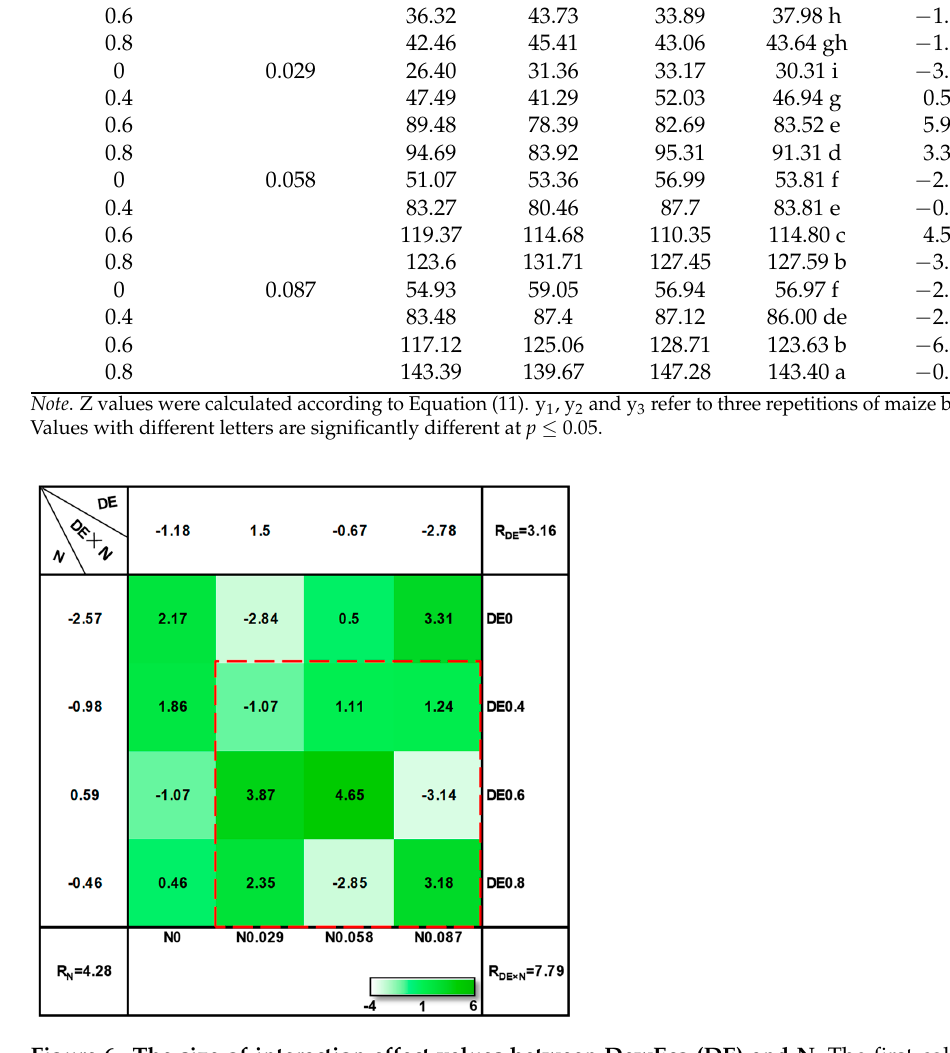
Figure 6. The size of interaction effect values between DewEco (DE) and N. The first column’s data refer to a i , which is the average value of the corresponding Z value of various DewEco dosages; the first-row’s data refer to b j , which is the average value of the Z values of various N dosages. R DE , R N and R DE×N refer to the range of a i, b j and ab ij . R DE , R N and R DE×N were calculated (12), and actual values were used to make heat maps. The red box represents the interaction effect between DewEco and N mixed application at each dosage.